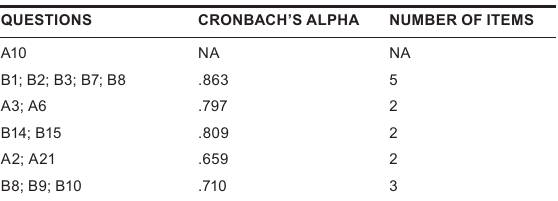
TABLE 18 Reliability statistics for paired